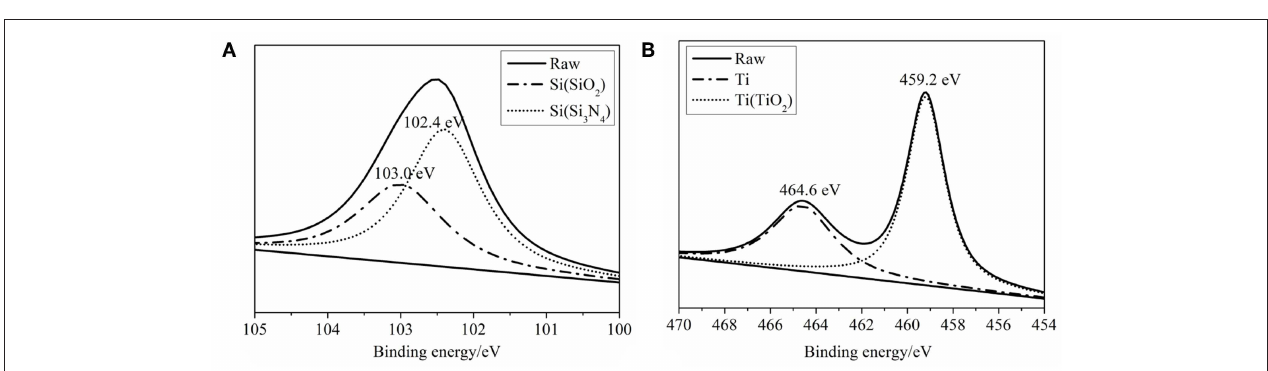
FIGURE 5 | XPS results of the worn surface of the titanium alloy disc against the silicon nitride pin at a load of 10 N: (A) Si 2p and (B) Ti 2p .